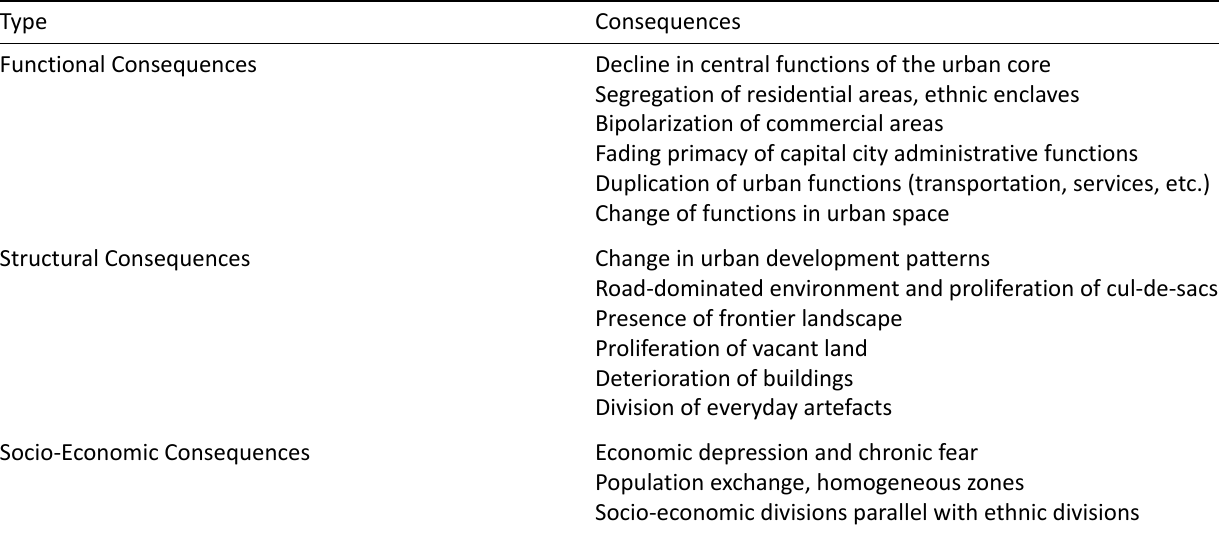
Table 2. Urban consequences of the divisions in